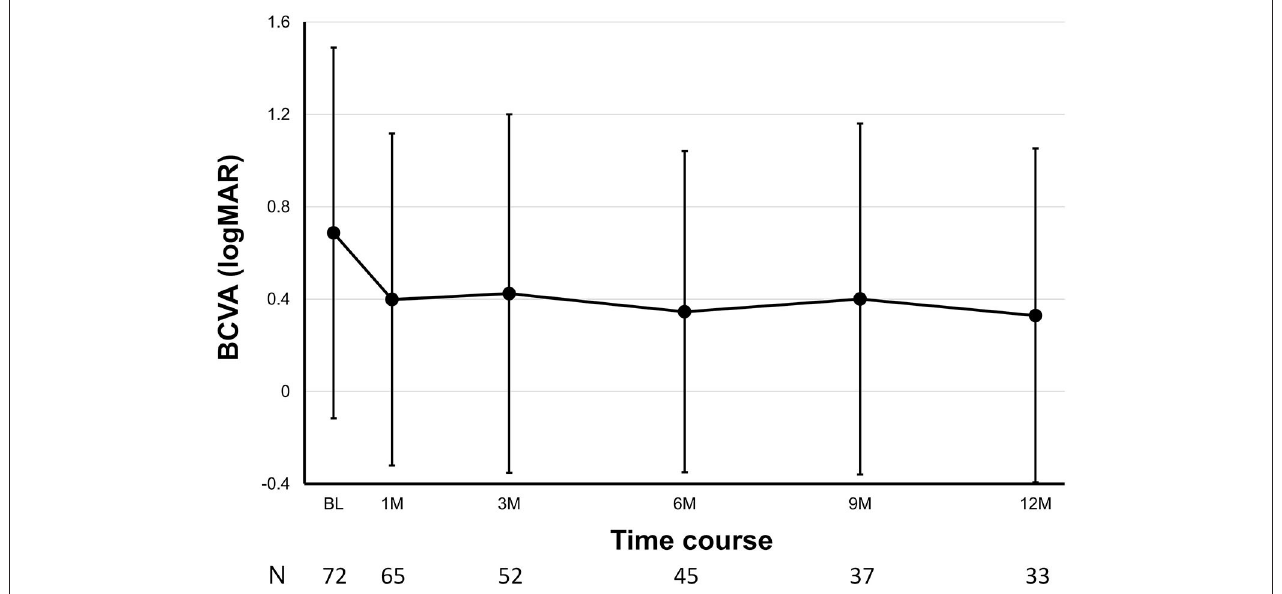
FIGURE 1 | Post-operative changes in best-corrected visual acuity (BCVA) over time. Number of eyes (N) is provided at each time point.